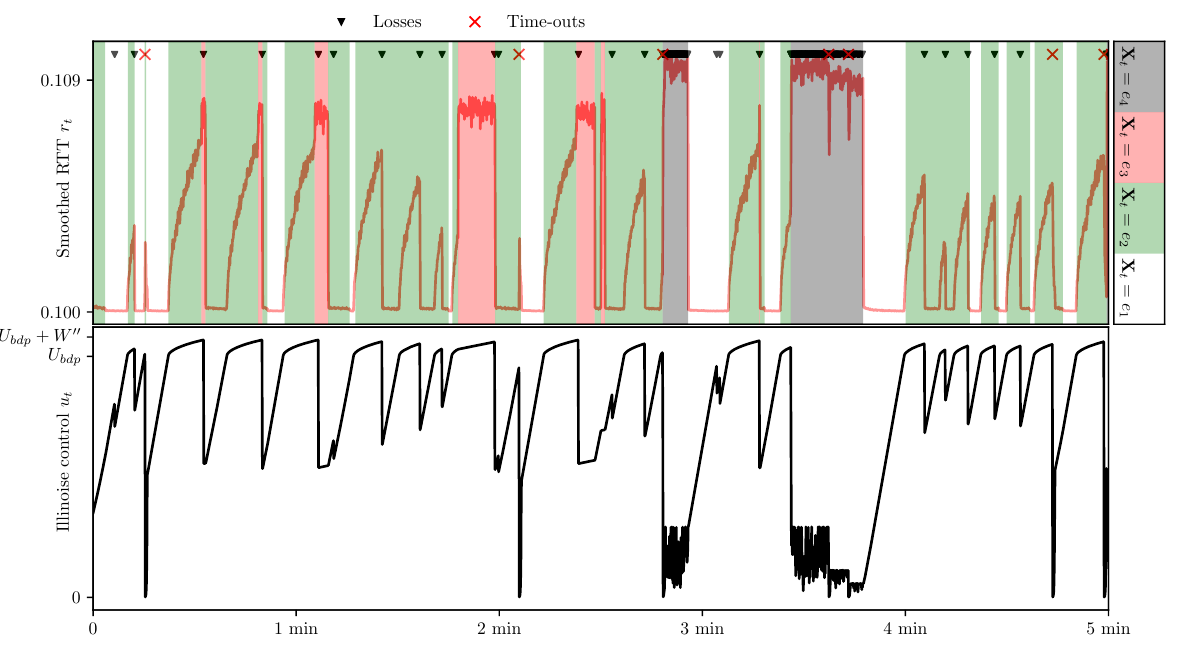
Figure 2. TCP channel simulation example for Illinois control